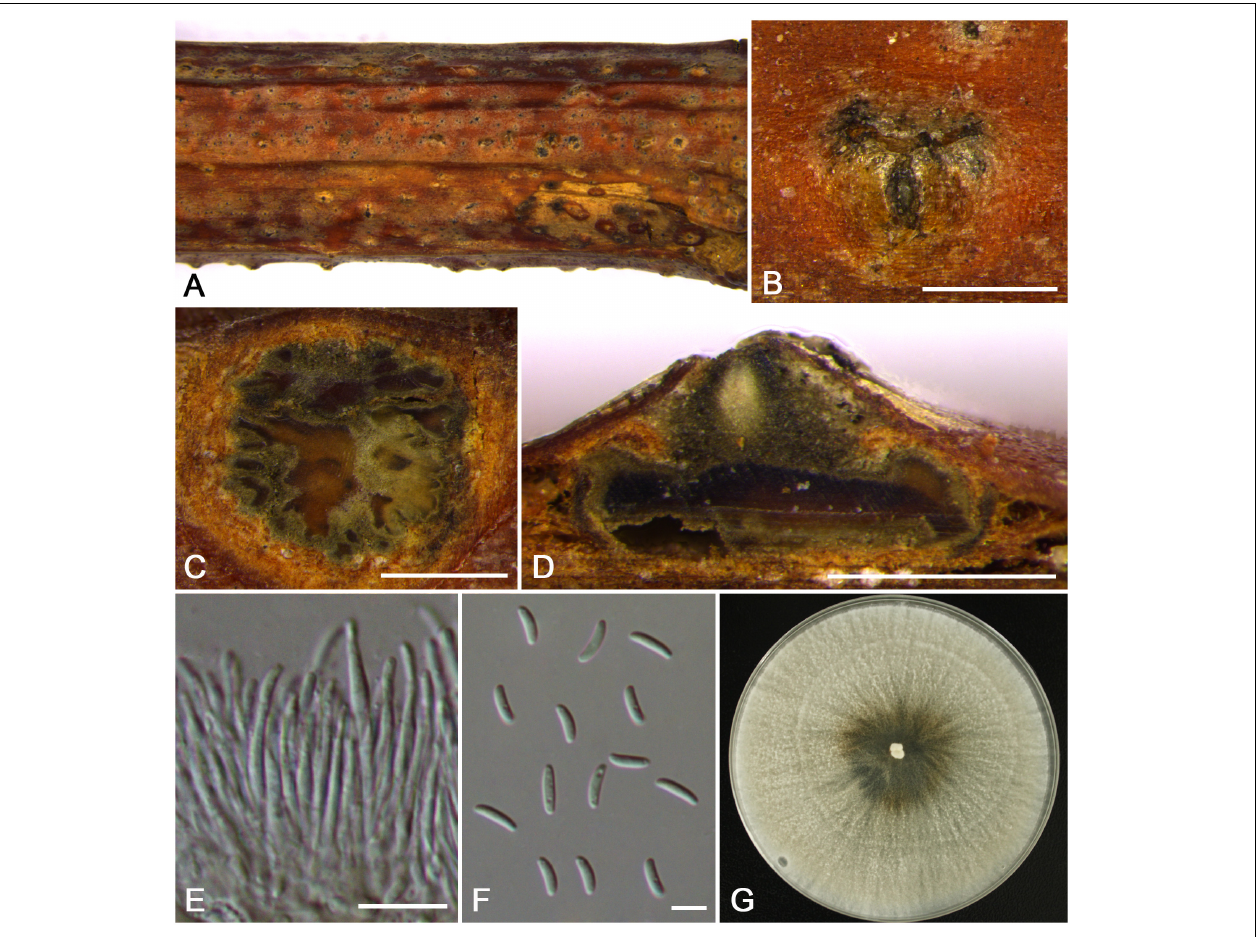
FIGURE 10 | Morphology of Cytospora pruni-mume from Prunus mume (CF 20197515). (A,B) Habit of conidiomata on twig. (C) Transverse section of conidioma. (D) Longitudinal section through conidioma. (E) Conidiophores and conidiogenous cells. (F) Conidia. (G) Colonies on PDA for 2 weeks. Bars: (B–D) = 500 µ m; (E) = 10 µ m; (F) = 5 µ